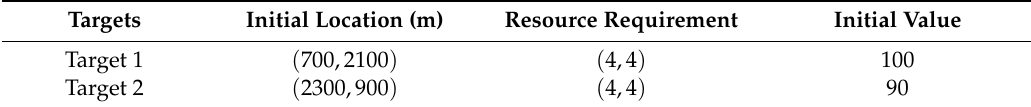
Table 5. Targets location and resource requirement.